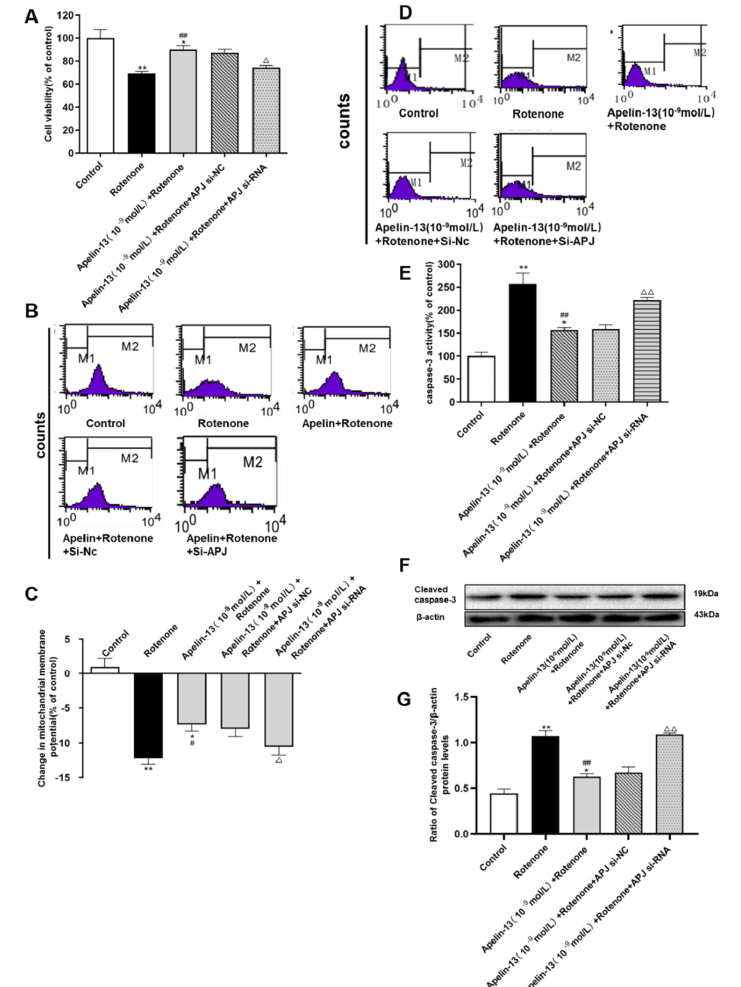
Figure 12. Effects of APJ siRNA on the neuroprotective effects of apelin-13 in SH-SY5Y cells. ( A ) The cell viability was tested by MTT assays, and is presented as percentage of control. Apelin-13 rescued rotenone-induced cell death, and this effect was prevented by APJ siRNA. ( B , C ) Fluorometric assays